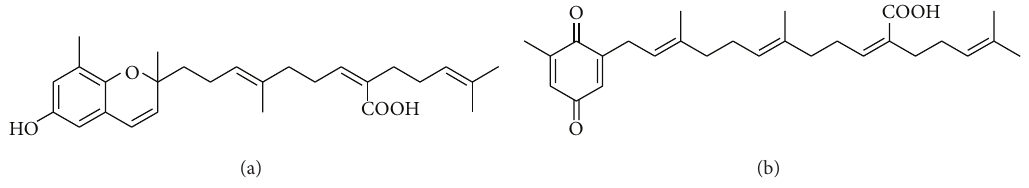
Figure 1: Structures of sargachromenol (a) and sargaquinoic acid